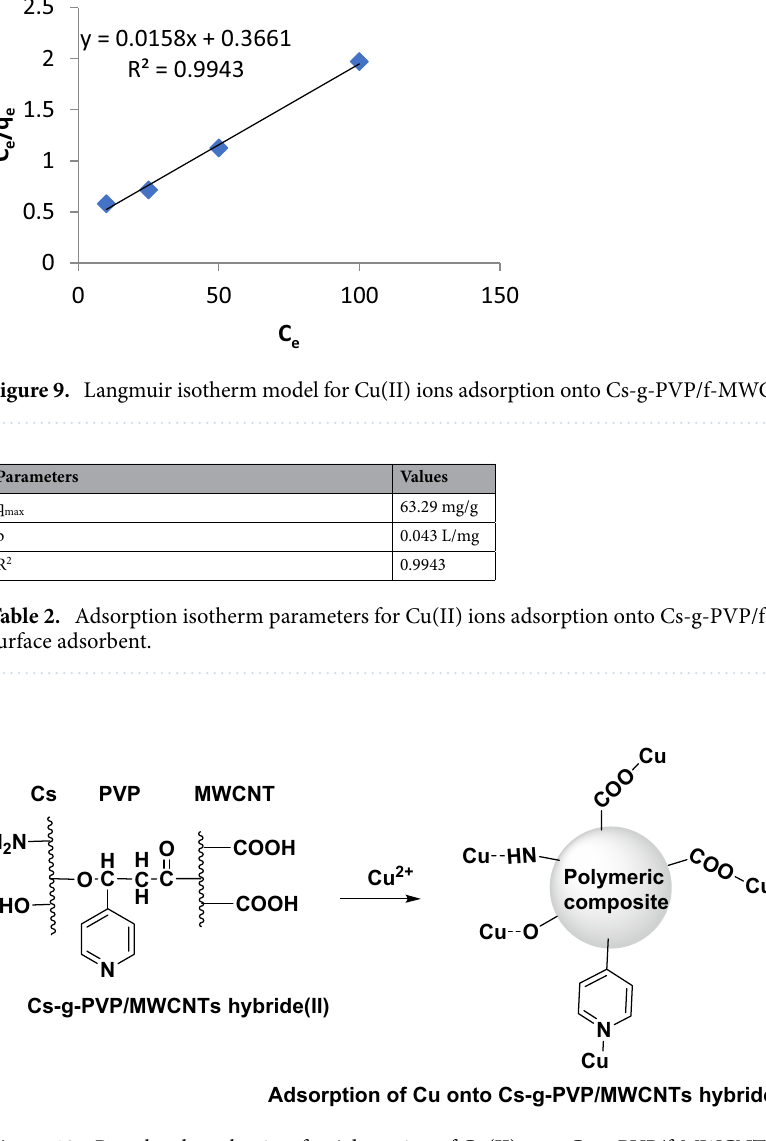
Figure 10. Postulated mechanism for Adsorption of Cu(II) onto Cs-g-PVP/f-MWCNT hybrids (II).